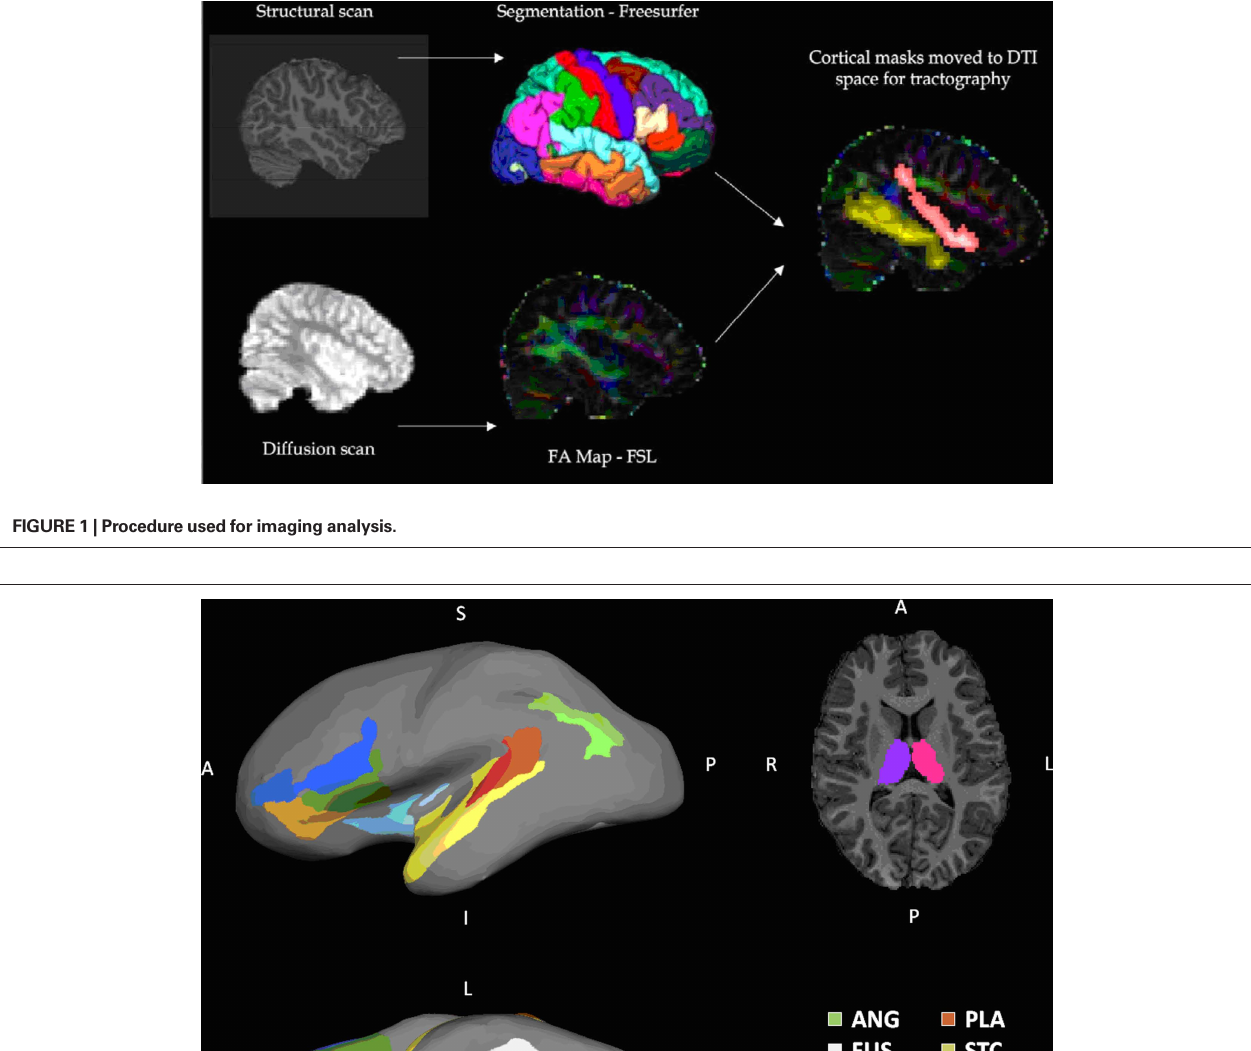
FiguRe 2 | Regions of interest. Shown on the left column are lateral and inferior views of ROIs rendered on the inflated surface of a left hemispherical brain. On the right column is a transverse slice of brain showing THA. Eighteen ROIs identified in this paper are labeled in the following manner: a prefix for